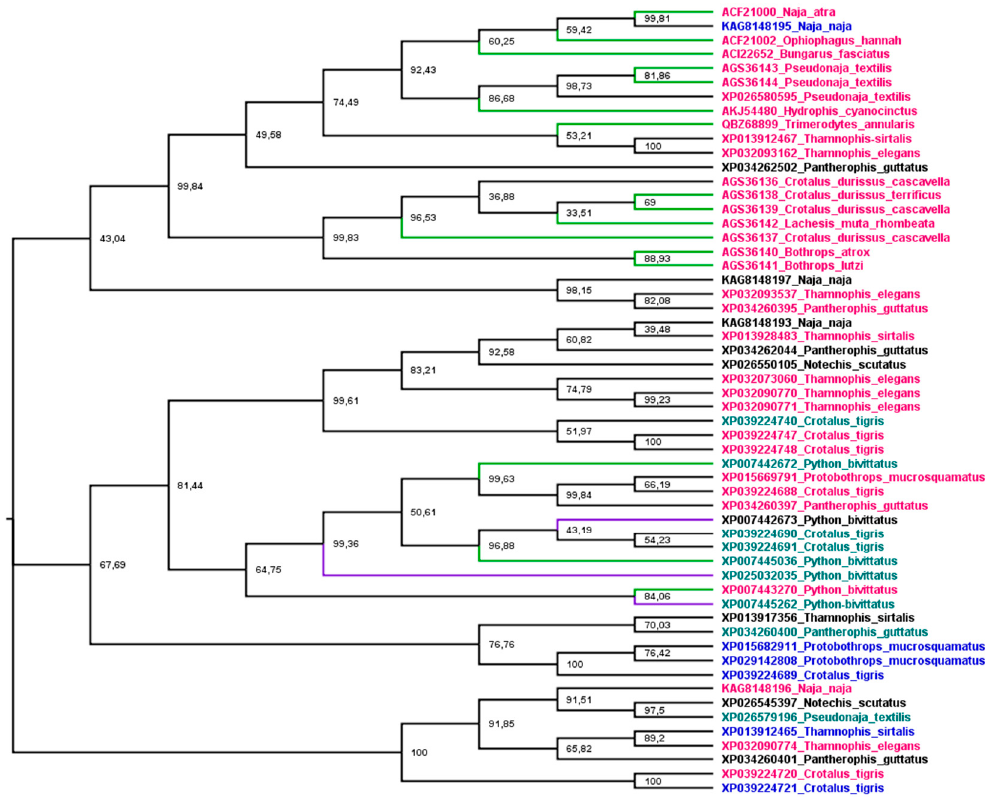
Figure 4. Phylogenetic tree of snake cathelicidins. The tree was estimated based on maximum likelihood [153], and the Edge Support LR-ELW is shown in each node [154]. Details are described in the Supplementary Materials. Branches in green indicated sequences with antimicrobial activity, purple branches indicate no activity, and black ones were not tested. Sequence names in purple indicate net charge <5, in green 5<10, red >10, and black, not determined, except XP007442673, which shows − 4 as net charge at pH 7.